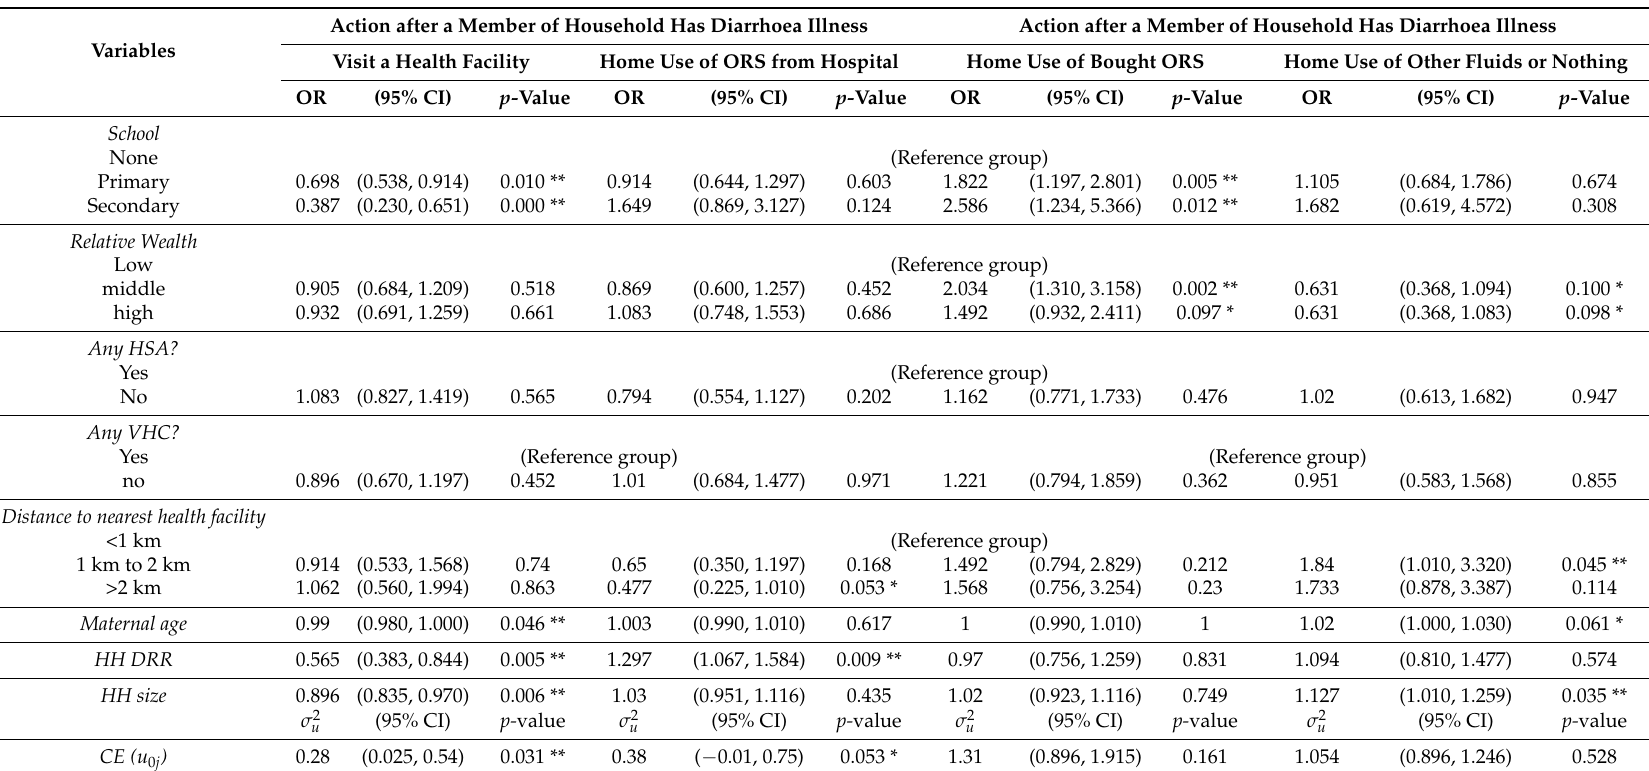
Table 3. Multilevel logistic regression models to identify determinants of household care-seeking behaviour when a family member has diarrhea.